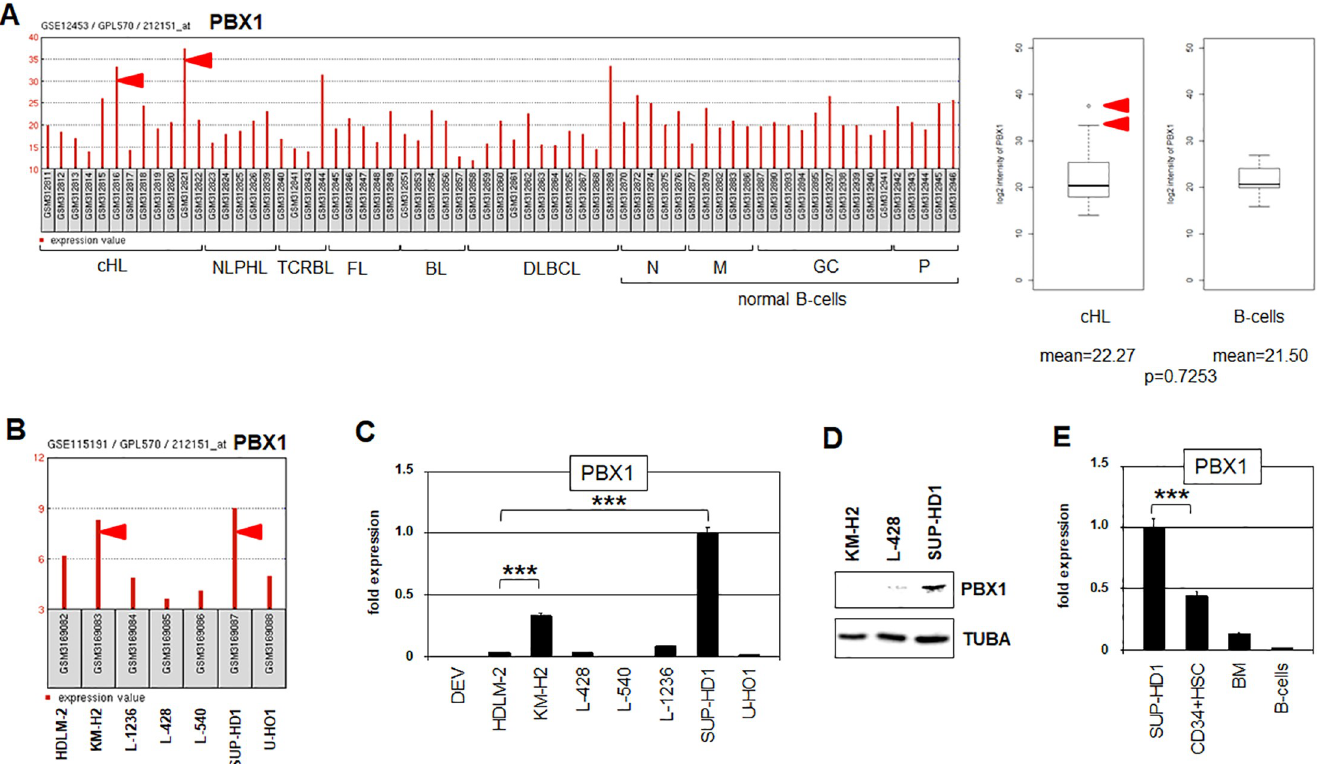
Fig 2. PBX1 expression in HL patients and cell lines. (A) PBX1 expression levels in HL patients according to dataset GSE12453 (left). Statistical analysis of PBX1 expression in cHL patients and normal B-cells using dataset GSE12453. The red arrow heads indicate two patients with highest PBX1 levels. Overall the difference between patients and controls is not significant (right). BL: Burkitt lymphoma, cHL: classical HL, DLBCL: diffuse large B-cell lymphoma, GC: germinal center B-cells, FL: follicular lymphoma, M: memory B-cells, NLPHL: nodular lymphocyte-predominant HL, N: na ï ve B-cells, P: plasma B-cells, TCRBL: T-cell rich B-cell lymphoma. (B) PBX1 expression levels in HL cell lines according to dataset GSE115191. KM-H2 and SUP-HD1 showed the highest PBX1 levels. (C) RQ-PCR analysis of PBX1 in HL cell lines, confirming enhanced transcript levels in KM-H2 and SUP-HD1. (D) Western blot analysis of PBX1 in HL cell lines showing PBX1 protein in SUP-HD1 but not in KM-H2. TUBA served as loading control. (E) RQ-PCR analysis of PBX1 in HL cell line SUP-HD1 in comparison to primary cells: hematopoietic stem cells (HSC), bone marrow (BM), and peripheral B-cells.